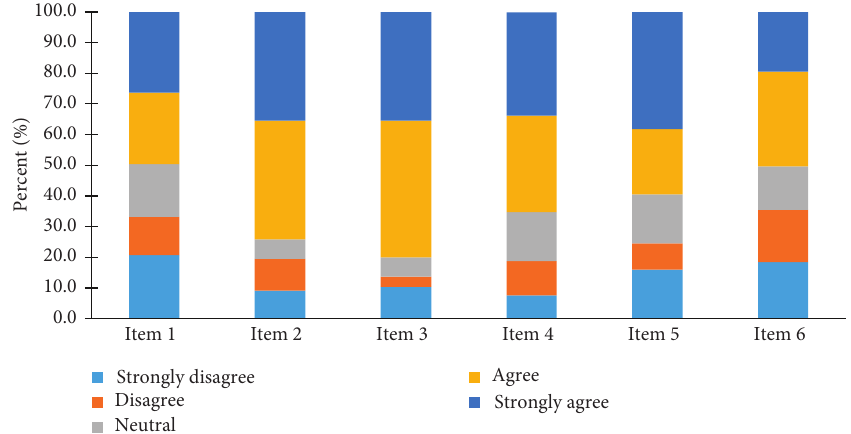
Figure 1: Attitudes of students at Tamale Technical Institute towards COVID-19.